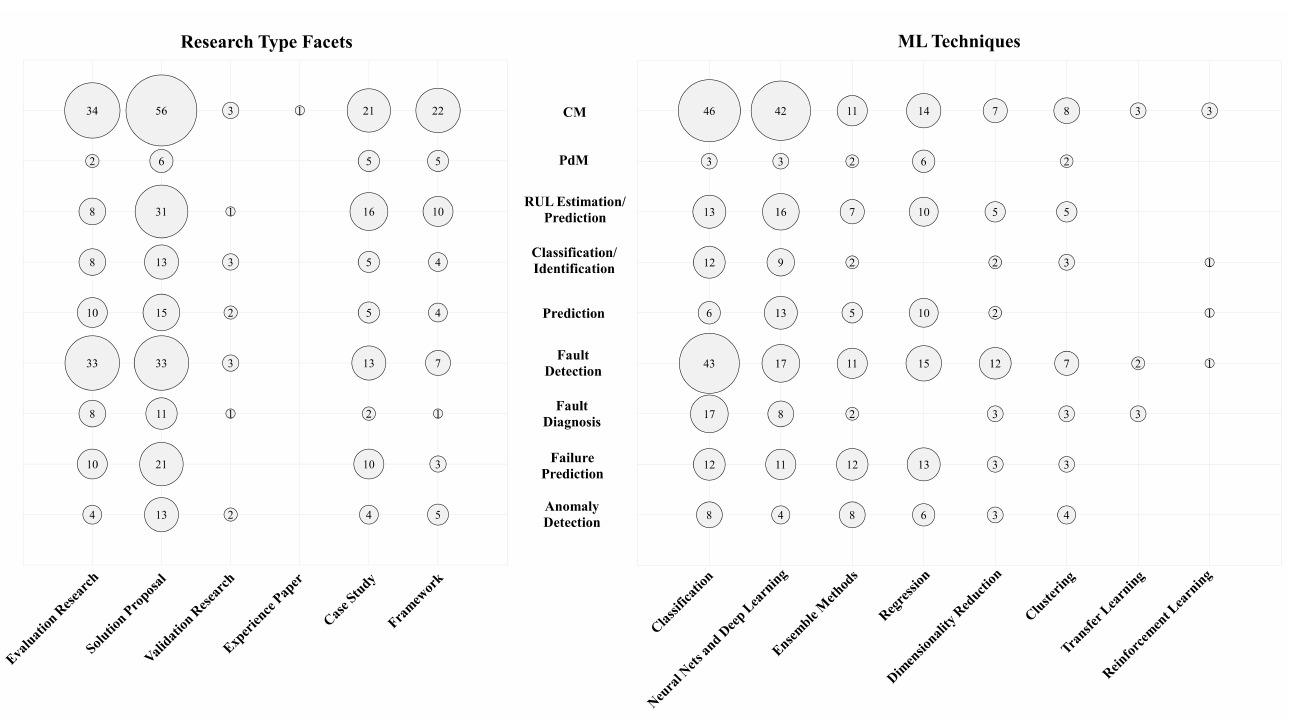
Figure 11. Applications set against research types and techniques in the form of a bubble chart (numbers in bubbles: number of